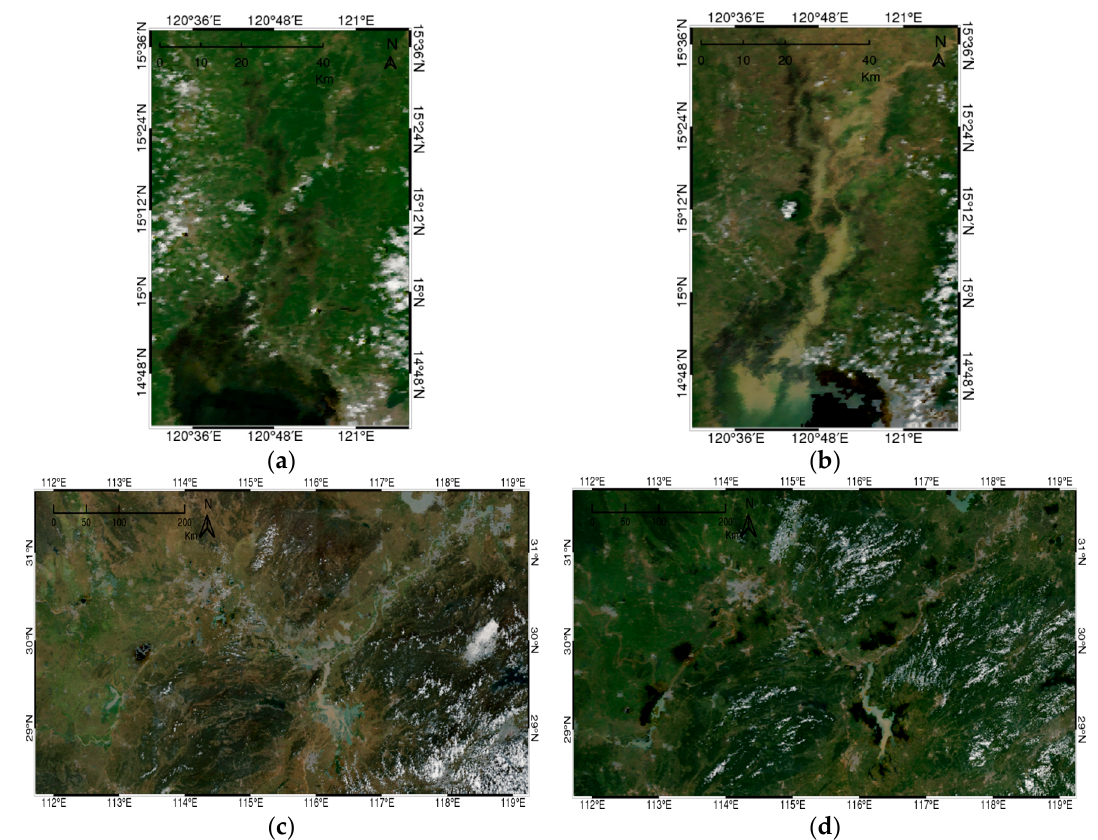
Figure 2. MODIS true color images combining bands 1, 4, and 3. Panels ( a , b ) show the Pampanga River area, highlighting the surface conditions before (16 September 2015 at 02:20 UTC) and after (25 October 2015 at 02:25 UTC) the flooding event, respectively. Panels ( c , d ) show the Poyang and Dongting Lakes focusing on the surface conditions before (27 March 2016 at 03:00 UTC) and after (28 July 2016 at 02:40 UTC) the flood event, respectively.